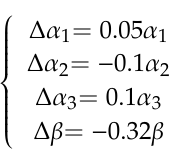
Table 4. Performance of the proposed method and PID controller with model uncertainties.